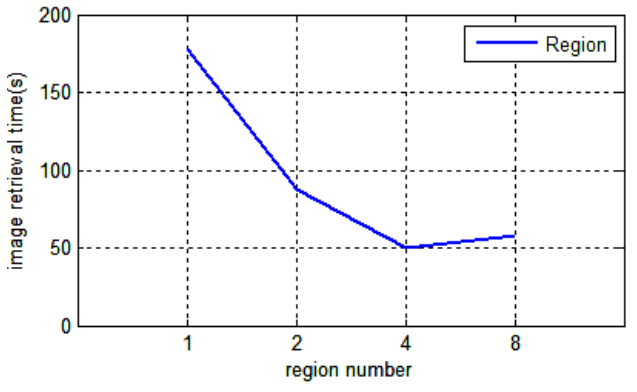
Figure 7. Comparisons on different number of Region